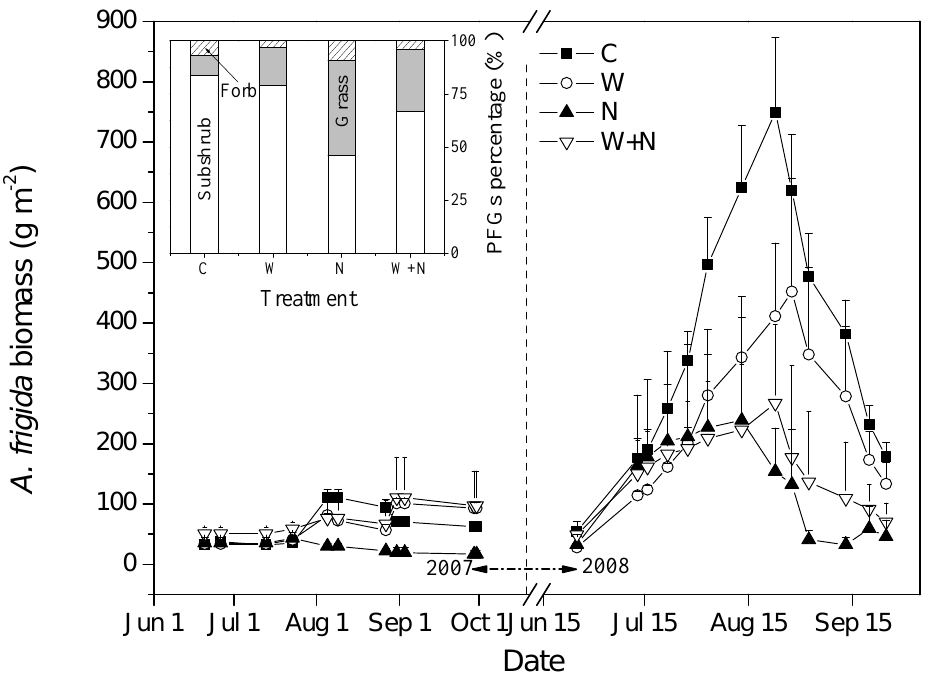
Fig. 2. Temporal variation of Artemisia frigida biomass (mean+1SE) in the control (C), warming (W), N addition (N), and warming+N addition (W+N) plots. Interior figure at top left corner shows the mean percentage of different plant functional groups (PFGs) biomass to gross biomass in the four treatments for two years ( Artemisia frigida is the only subshrub